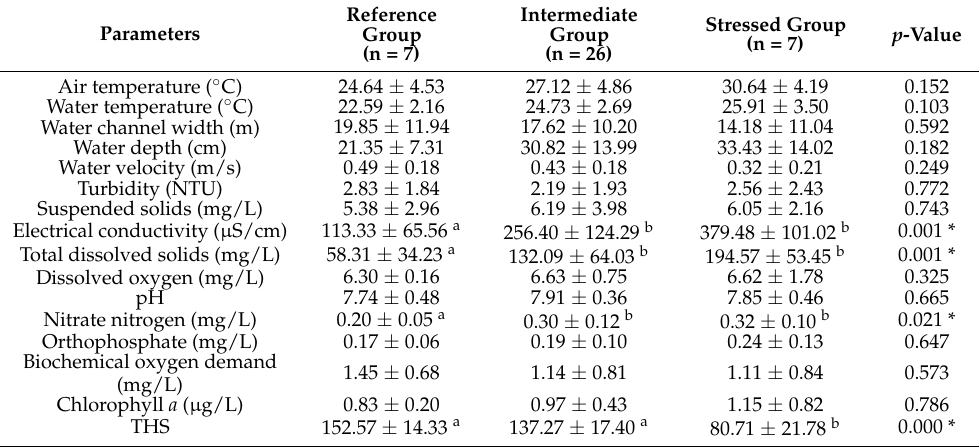
Table 2. Environmental variables of reference, intermediate, and stressed sites. Data are expressed as Mean ±